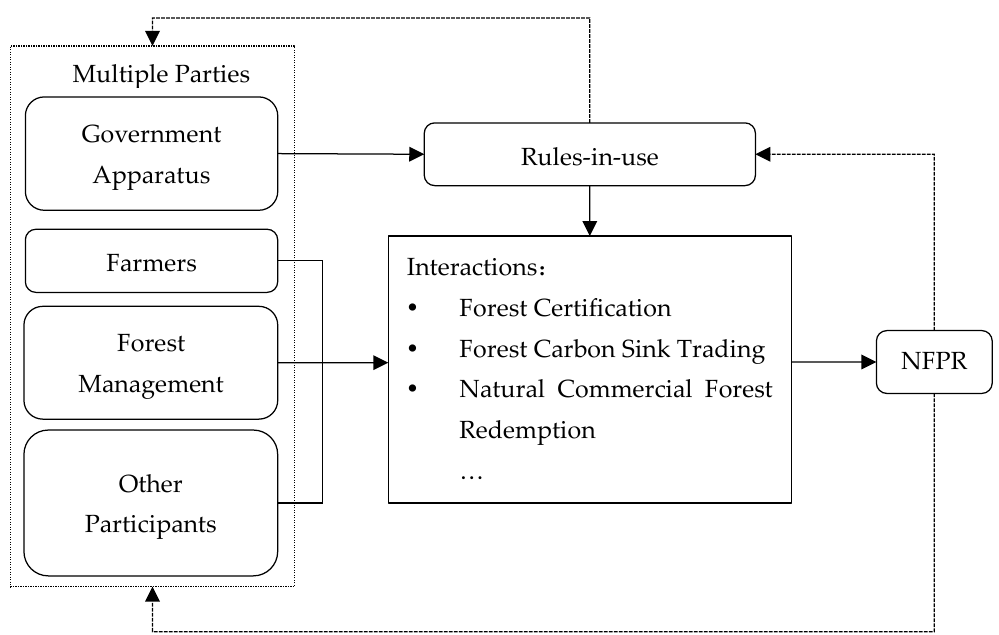
Figure 1. The process of the participation pf multiple parties in NFPR.